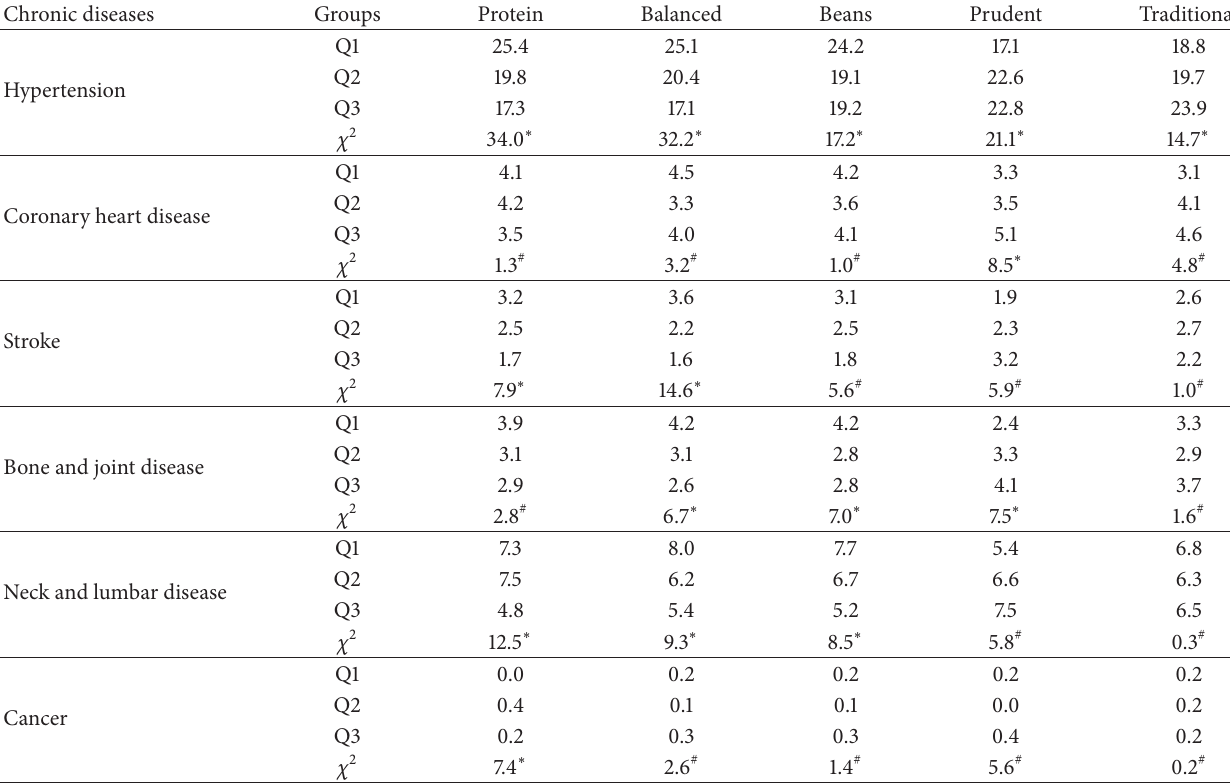
Table 4: Chronic diseases prevalence rate (%) by dietary